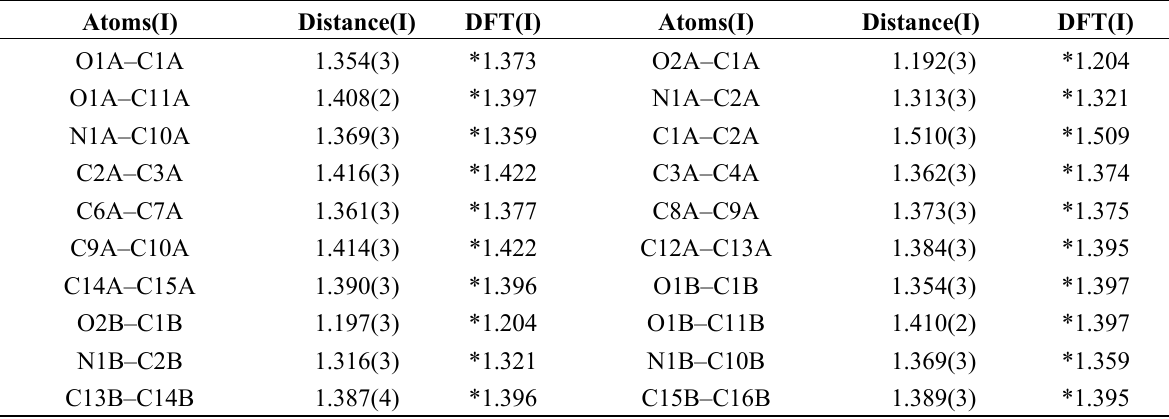
Figure 2. ( a ) Molecular structure of C 16 H 11 NO 2 (I) , showing the atom numbering scheme with 30% probability ellipsoids; ( b ) Packing diagram for (I) viewed along the b axis. H atoms not involved in hydrogen bonding have been removed for clarity. Table 1. Selected crystal and DFT* bond lengths (Å), bond angles (°), and torsion angles (°) for (I) , C H NO 16 11 2